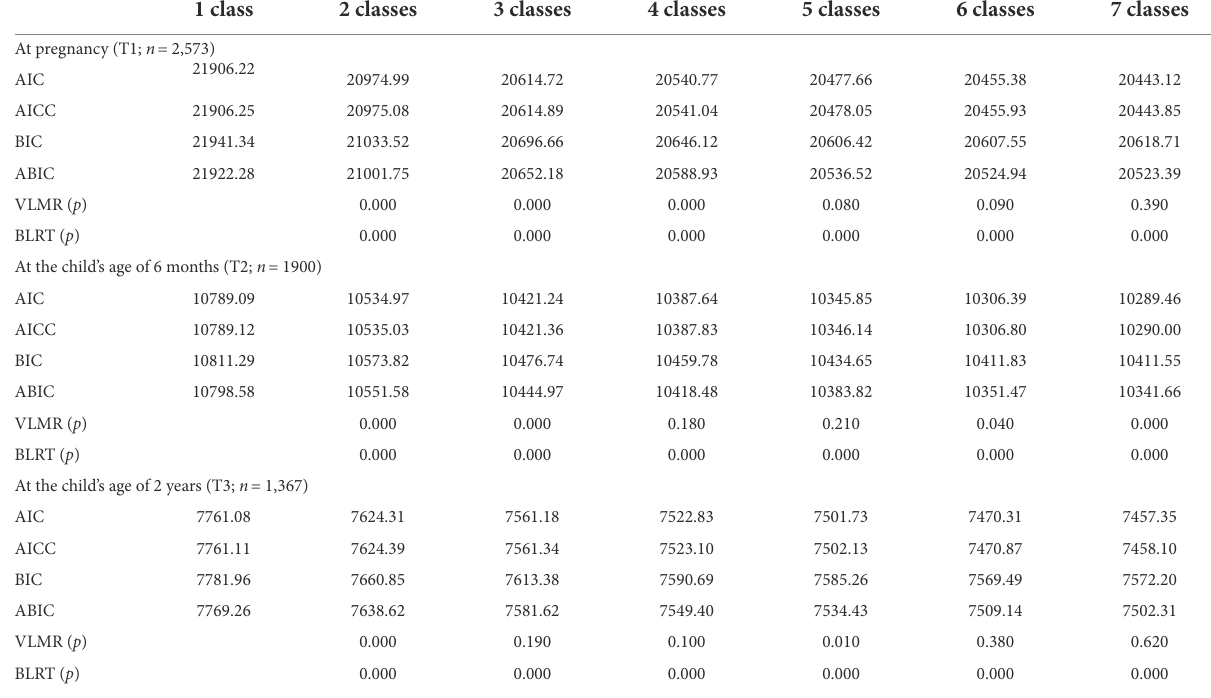
TABLE 2 Fit Indices from the cross-sectional latent class